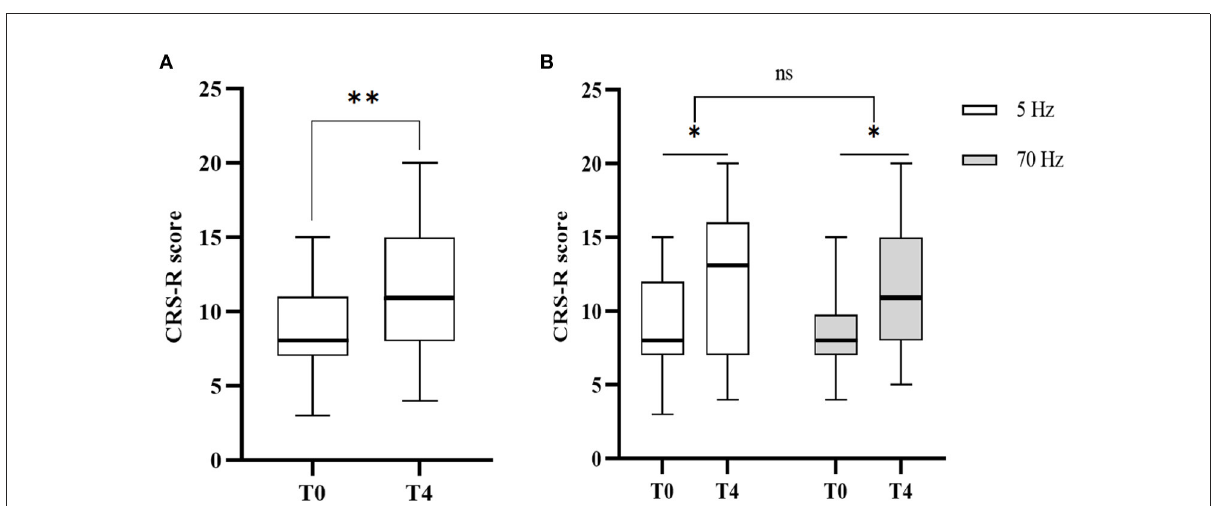
FIGURE8 CRS-R changes before the treatment (T0) and 3 months follow up (T4). (A) CRS-R changes before and after the treatment. Wilcoxon signed-rank test indicates significant differences (** p < 0.01). (B) CRS-R changes in different frequency groups before and after the treatment. Two-way RMANOVA indicates significant differences (* p < 0.05), ns not statistically